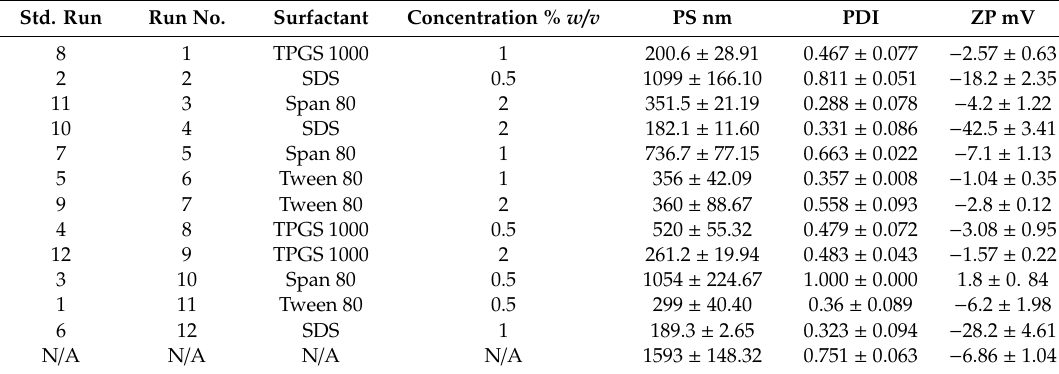
Table 3. Summary of results from general factorial experiments.